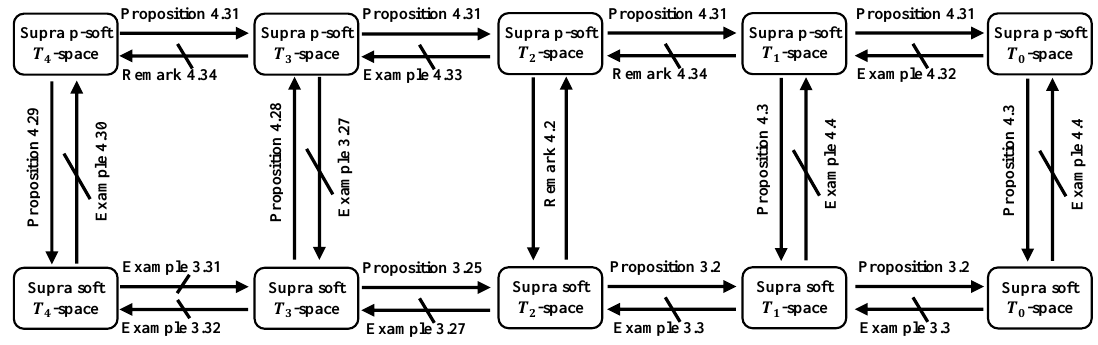
Figure 1: The relationships among some types of supra soft separation